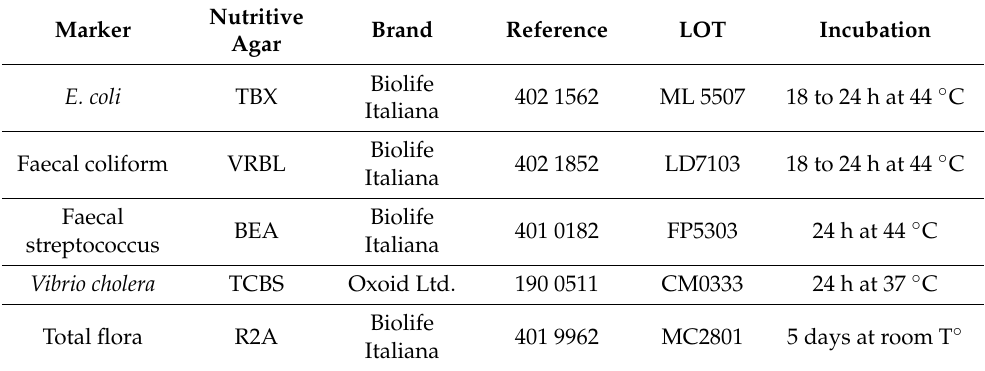
Table 1. Characteristics of nutritive agars used.